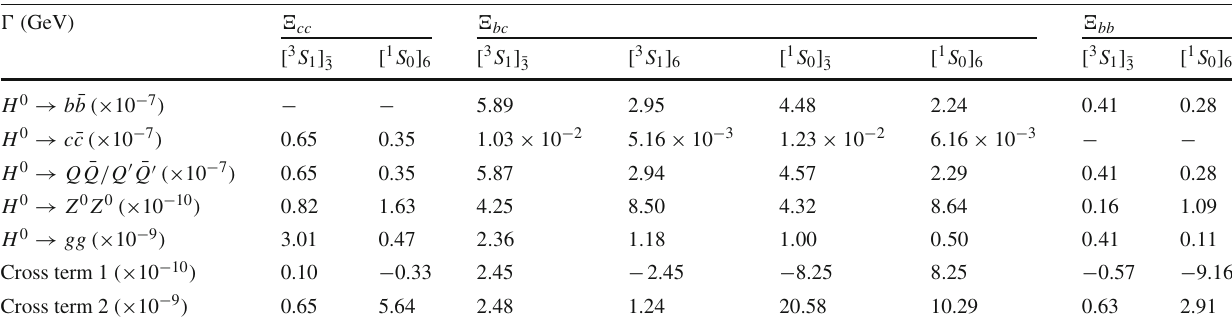
Table 2 The decay widths for the process H 0 → b ¯ b / c ¯ c / Z 0 Z 0 / gg → (cid:2) + ¯ Q (cid:3) + ¯ Q , where Q and Q (cid:3) denote the heavy c or b quark. QQ (cid:3) Cross term 1 stands for the cross term between H 0 → Q ¯ Q / Q (cid:3) ¯ Q (cid:3)